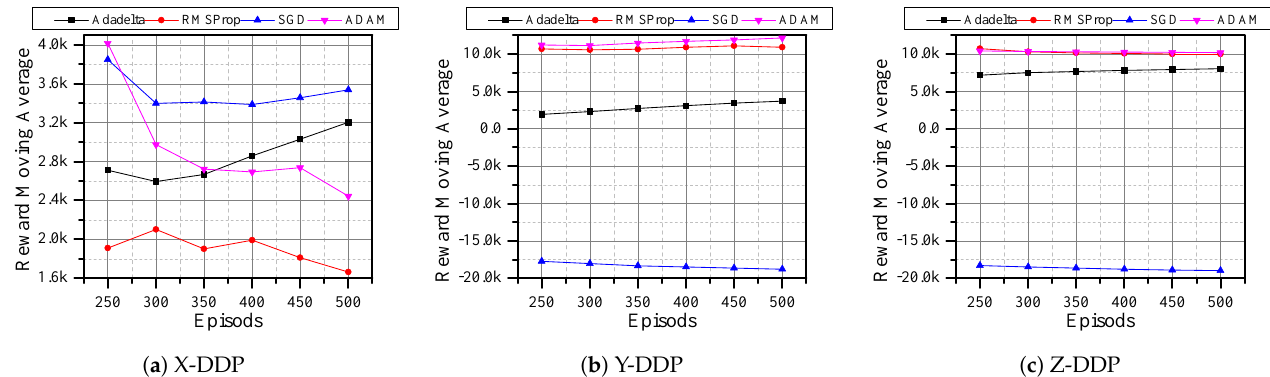
Figure 7. DQN and different optimizers with 100 steps/episode for a total of 500 episodes using MSE reward function.